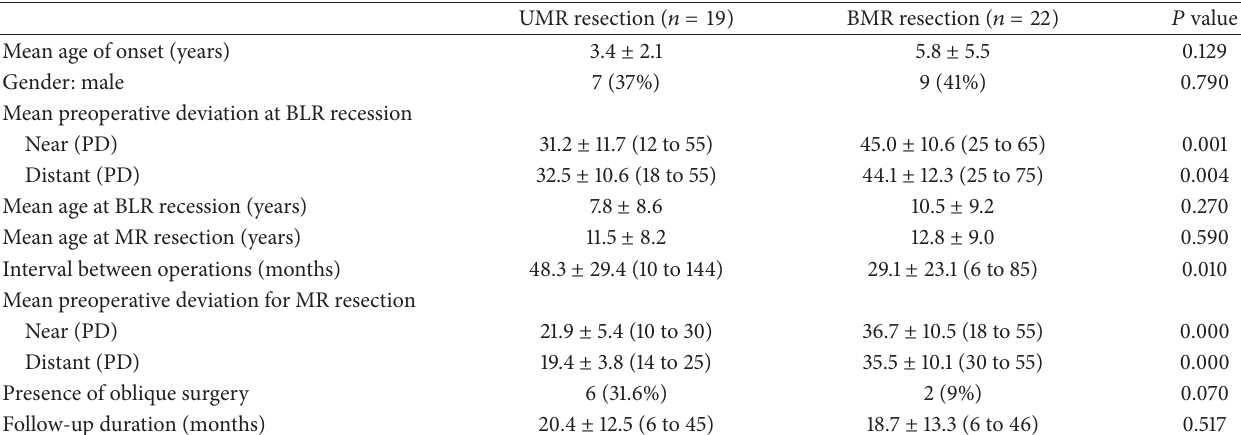
Table 1: Preoperative patient characteristics.